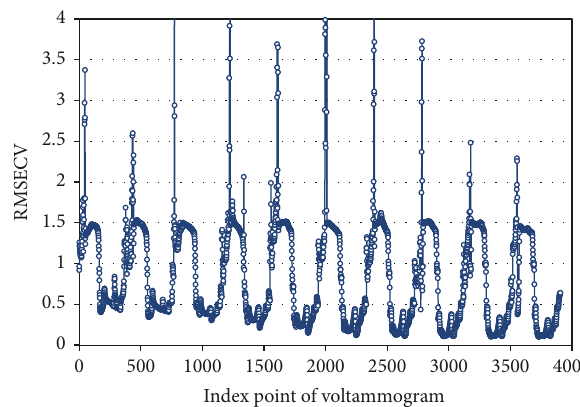
Figure 6: RMSECV calculated with IPLS for 125 nonoverlapping intervals of width of 31 variables and 1 interval of 36 variables of mean centered voltammograms for 𝐹 = 1 .